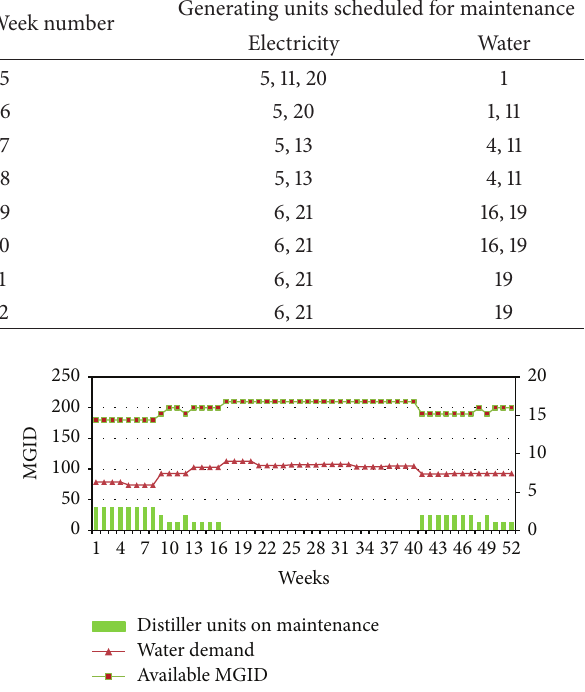
Table 2: Maintenance schedules for 21 units of electricity and 21 units of water.